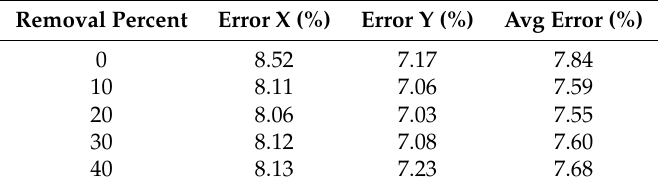
Table 1. Average errors for various removalPercent values.